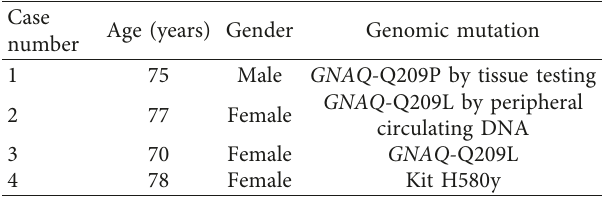
Table 1: Different types of genomic mutations in patients with metastatic melanoma of the liver.